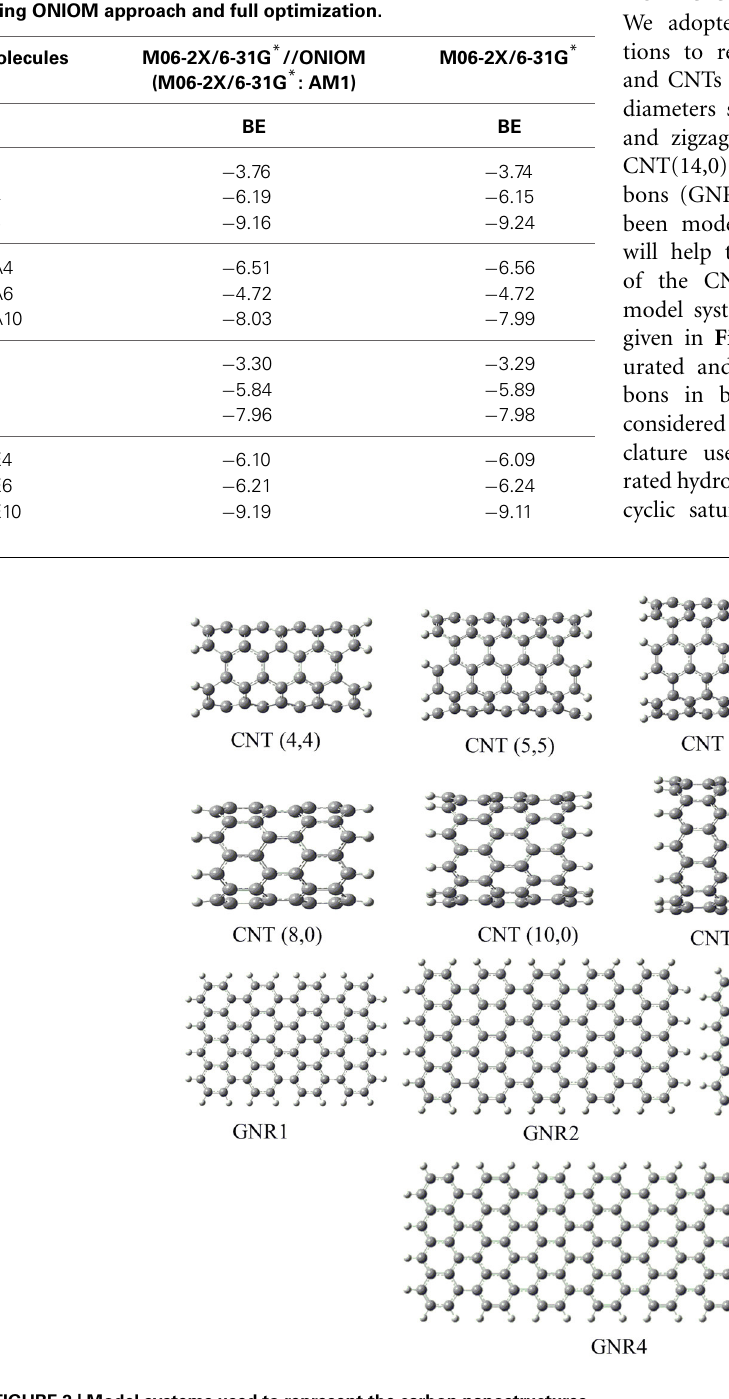
FIGURE 2 | Model systems used to represent the carbon nanostructures.